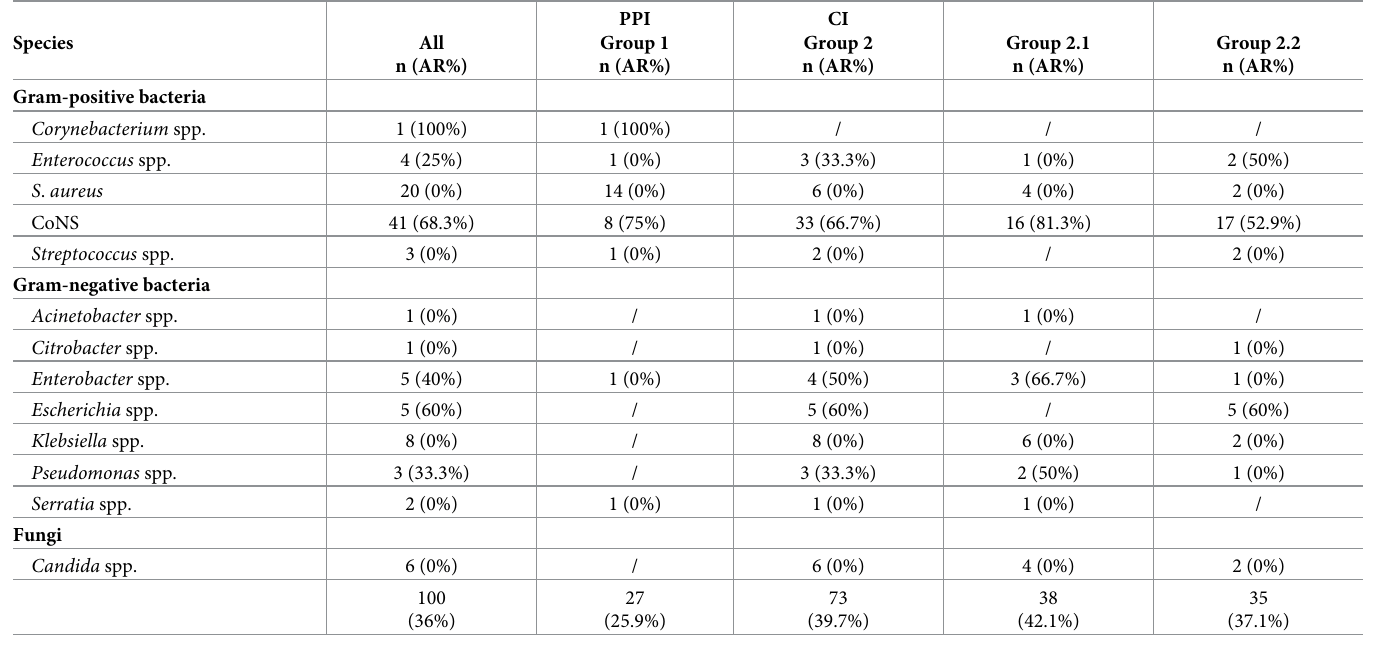
Table 3. Isolates with distinct susceptibility tests and frequency of strains with acquired resistances in port pocket infections and in catheter